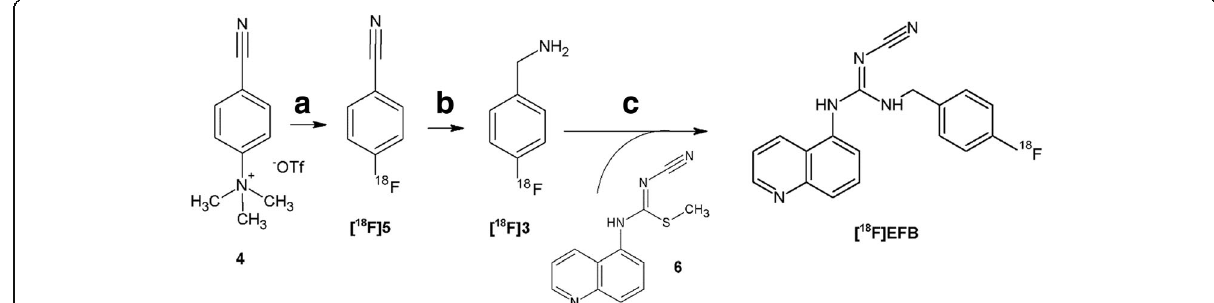
Fig. 2 Radiosynthetic route to [ 18 F]EFB. a [ 18 F]KF.K222, 15 min, 110 °C in DMSO followed by tC18 Sep-Pak SPE. b 2:1 w / w NaBH 4 /Co(OAc) 2 in 2 mL:1 mL THF/H 2 O, 5 min followed by Strata-X-CW purification in acidic media. c Excess triethylamine, THF, 140 °C, HPLC purification and concentration on a light C18 Sep-Pak SPE